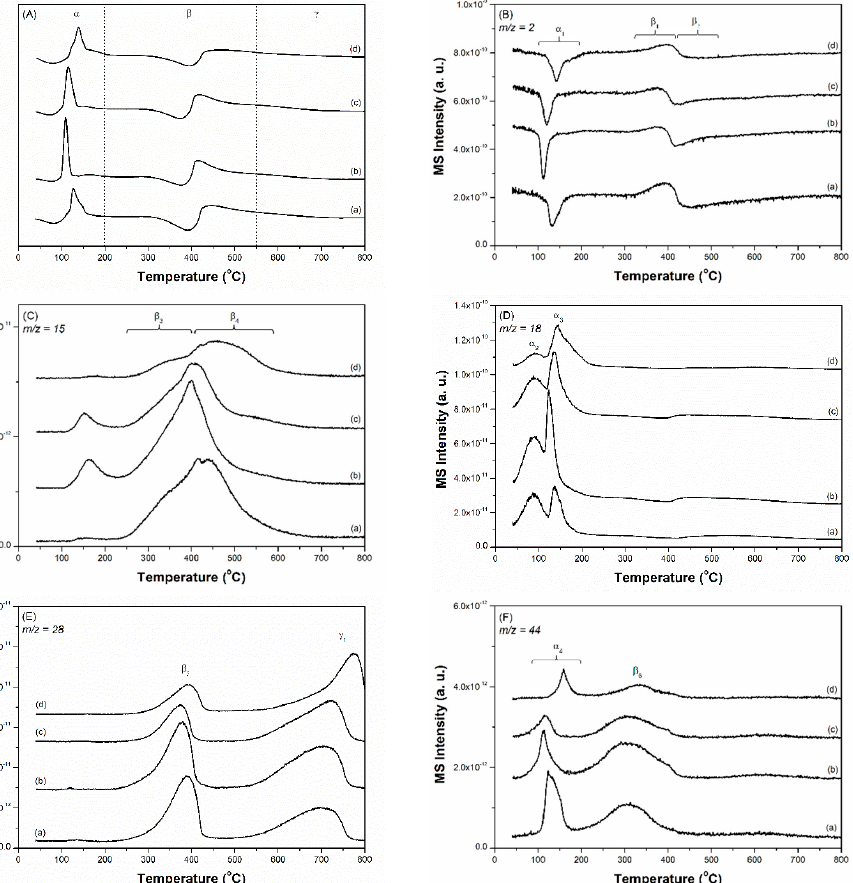
Figure 4. ( A ) Temperature-programmed reduction equipped with a thermal conductivity detector (TPR-TCD) and ( B – F ) temperature-programmed reduction equipped with a mass spectrometer (TPR-MS) profiles of freshly prepared catalysts. (a) 2.5Cs-10Ru/AC, (b) 2.5Cs-10Ru/MPC-15, (c) 2.5Cs-